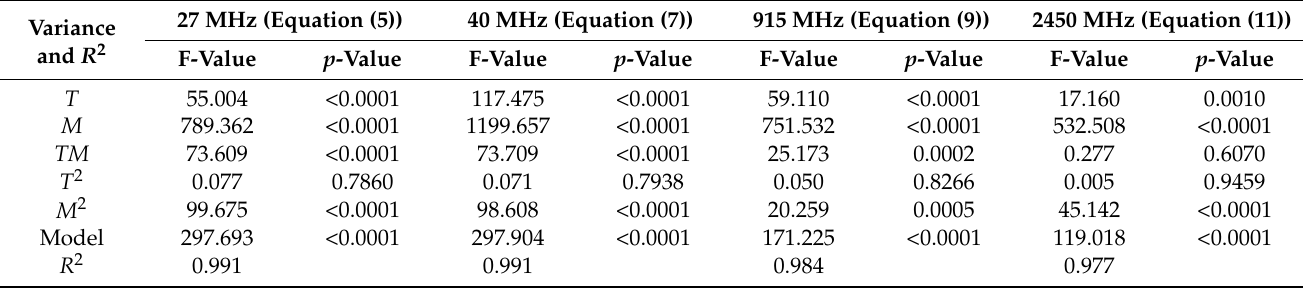
Table 4. Analysis of variance of regressed models of Equations (5), (7), (9), and (11) for wolfberries at four frequencies relevant to